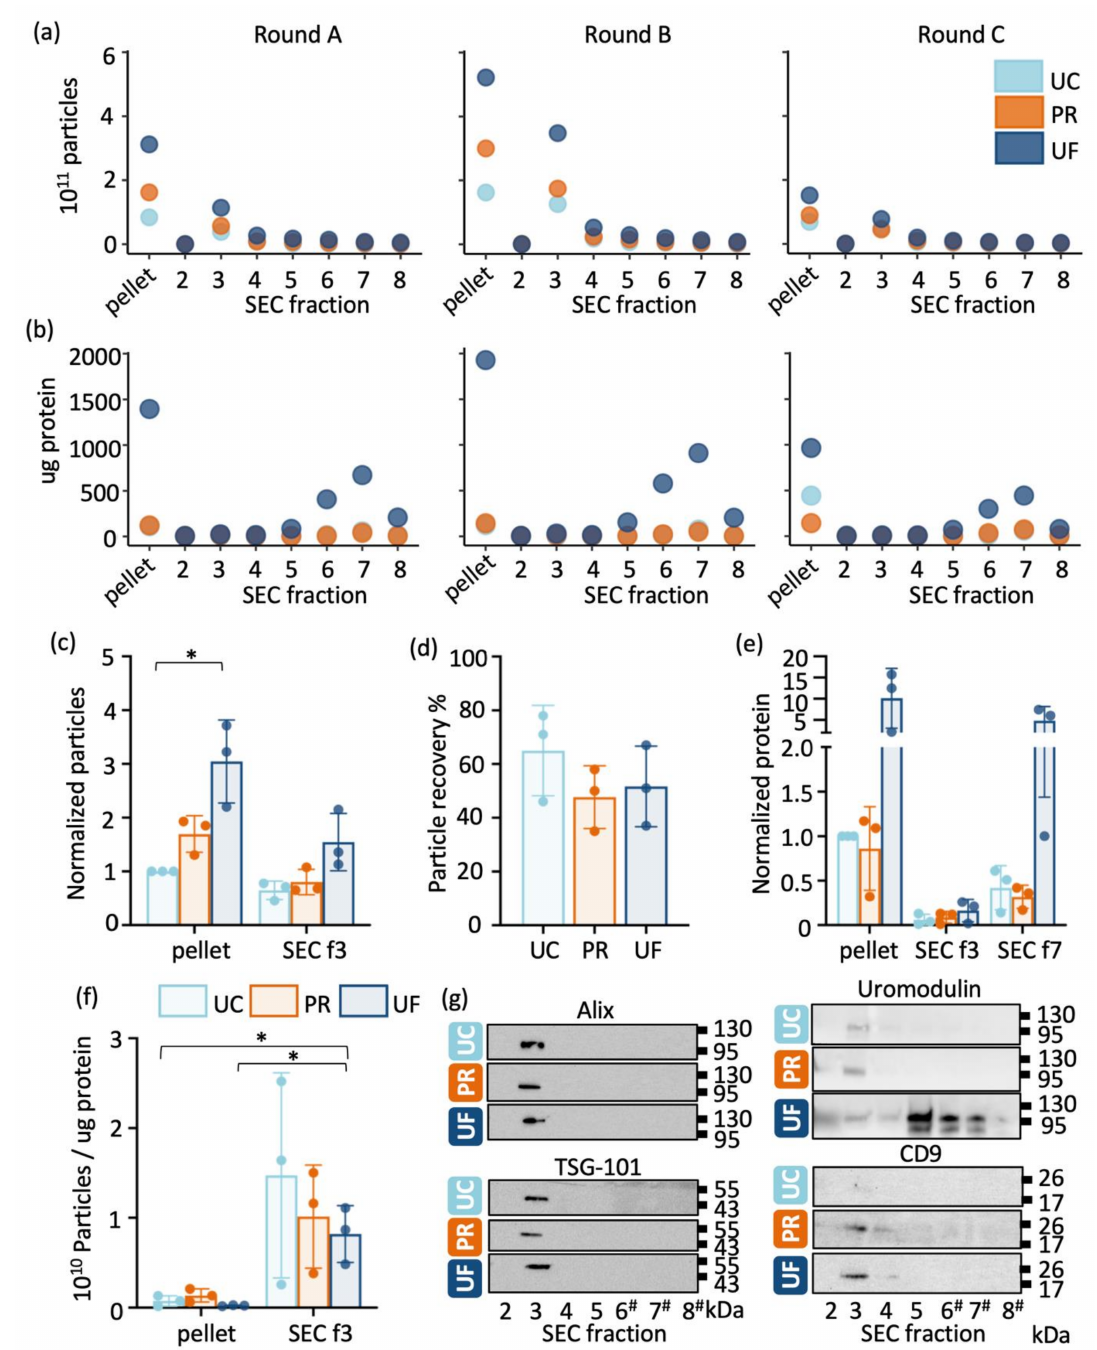
Figure 2. Comparison of EVs concentrated using three different methods (“pellet”) and following SEC purification: ( a ) Particle number measured with nanoparticle tracking analysis (NTA) and ( b ) protein amount from pellet and SEC fractions 2–8 from individual rounds. ( c ) Particle numbers from pellet and SEC fraction 3 (EVs) samples normalised to that of UC pellet in that round. ( d ) Particle recovery calculated by comparing particle yield between fraction 3 and corresponding pellet. ( e ) Protein concentration of pellets and SEC fractions 3 (EVs) and 7 (fraction with highest protein content) normalised to that of the UC pellet in that round. ( f ) Particle/protein ratio calculated from each pellet and SEC fraction 3. With UC+SEC and PR+SEC, the protein concentration was below the sensitivity limit of the assay and the values were estimated as described in the Materials and Methods section. Statistical comparison was not performed against estimated values. ( g ) Western blot analysis of vesicle markers Alix, TSG-101 and CD9 and the contaminating protein uromodulin in SEC fractions 2–8. # Because of high protein concentration, ultrafiltration fractions 6–8 were loaded with 5 µ L of the elute instead of 20 µ L for other samples. Data are presented as individual values, mean and standard deviation. * p <